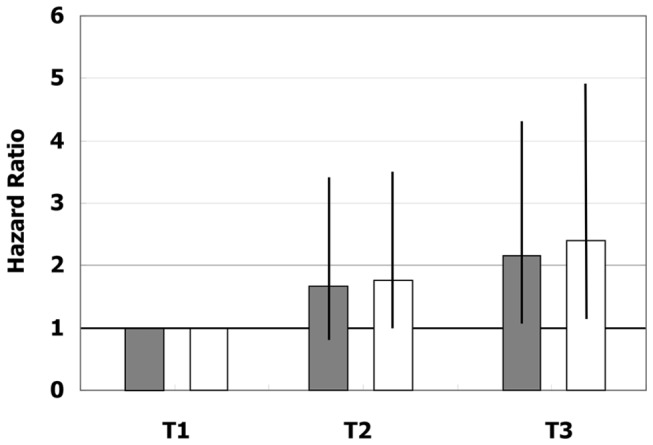
Hazard ratios of Cox regression models among the tertiles of plasma BNP in subjects with AF.Grey bars = age-sex adjusted model; White bars = multivariate model .